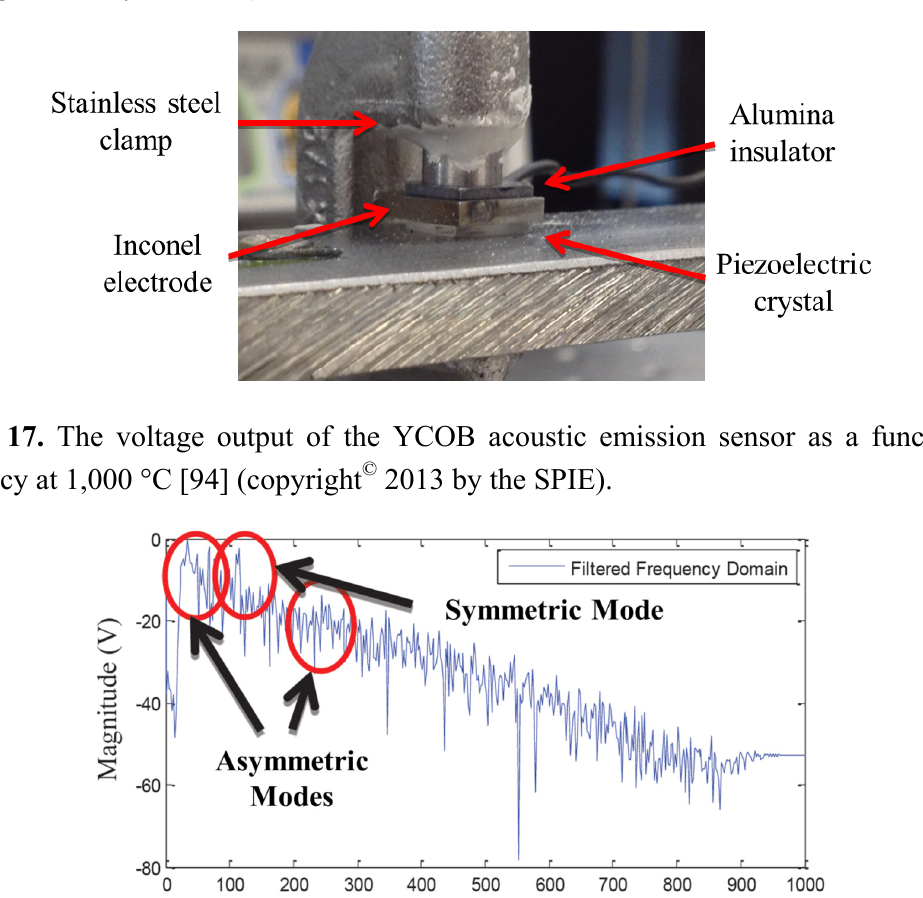
Figure 16. The assembly of the YCOB acoustic emission sensor for HT applications [94] (copyright 2013 by the SPIE).